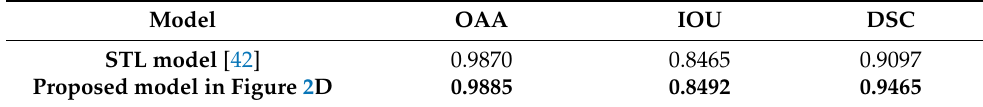
Table 4. Evaluation metrics of the models for road extraction performed by the authors. STL, single task